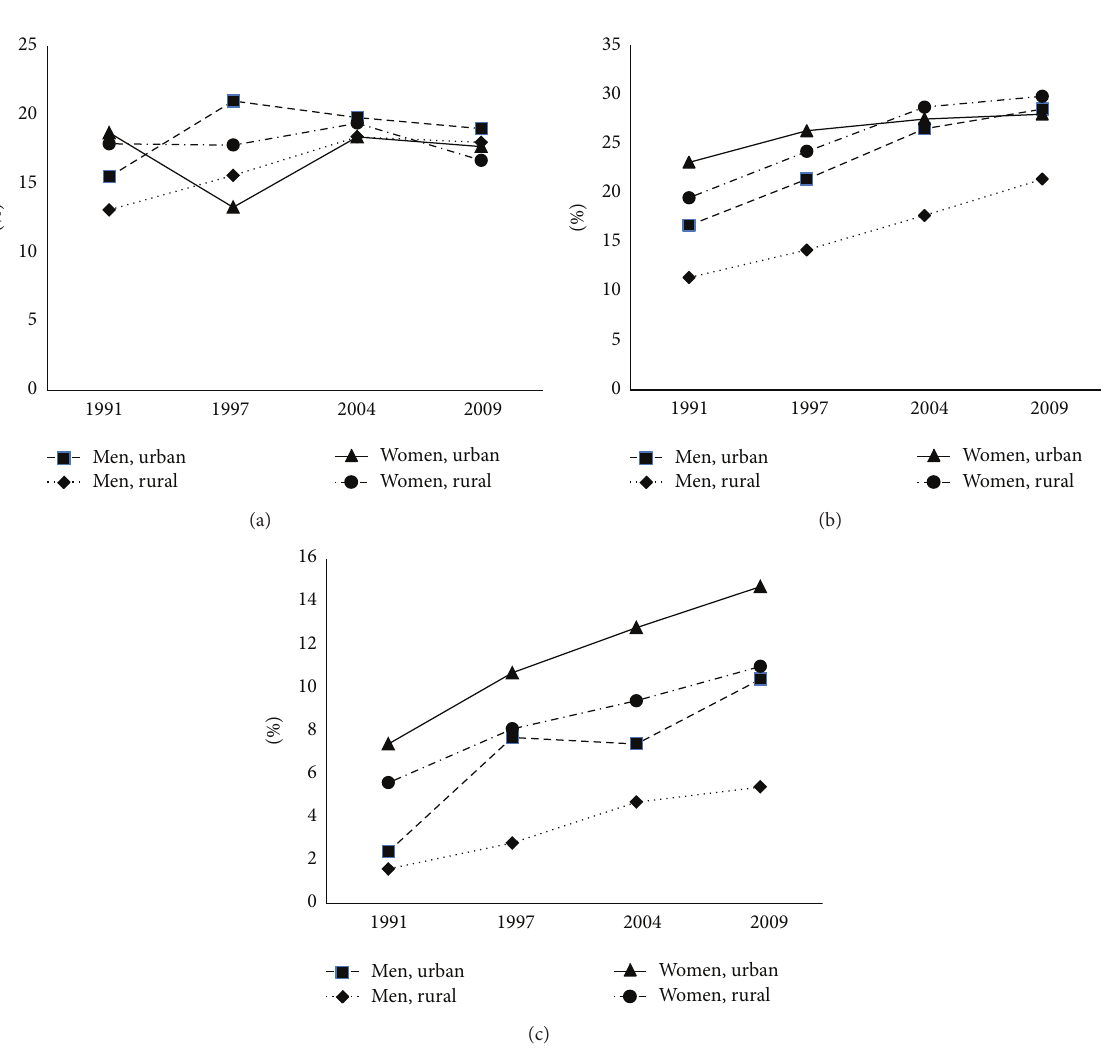
Figure 1: Age-adjusted prevalence of BMI categories: (a) BMI 23– < 25 kg/m 2 , (b) BMI 25– < 30 kg/m 2 , and (c) BMI ≥ 30 kg/m 2 by sex and area of residence among Thai adults aged ≥ 20–59 years, Thai NHES